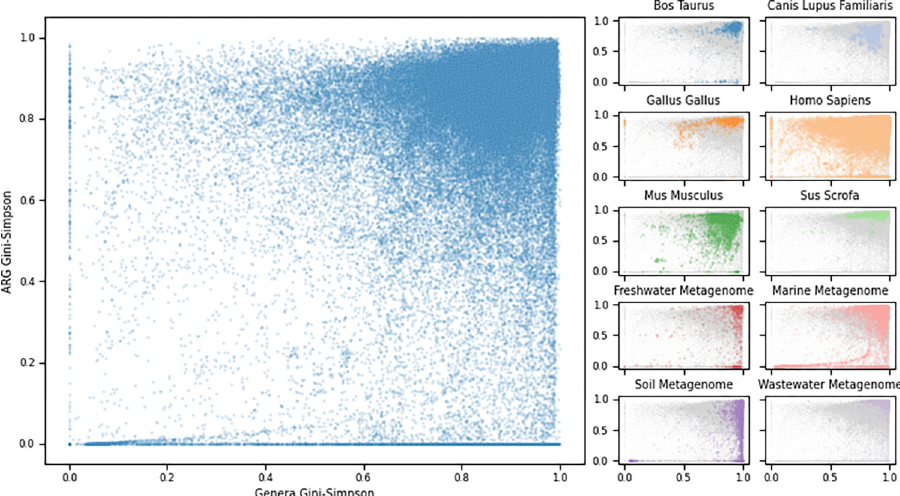
Fig 5. The genus–ARG diversity relationship for all metagenomic samples. The Gini–Simpson diversity indexes were calculated on genus categories (x-axis) compared to ARG levels (y-axis). Left: scatterplot of all samples. Right: samples colored by selected host or environmental origins. The data underlying this figure can be found at https://doi. org/10.5281/zenodo.6919377.